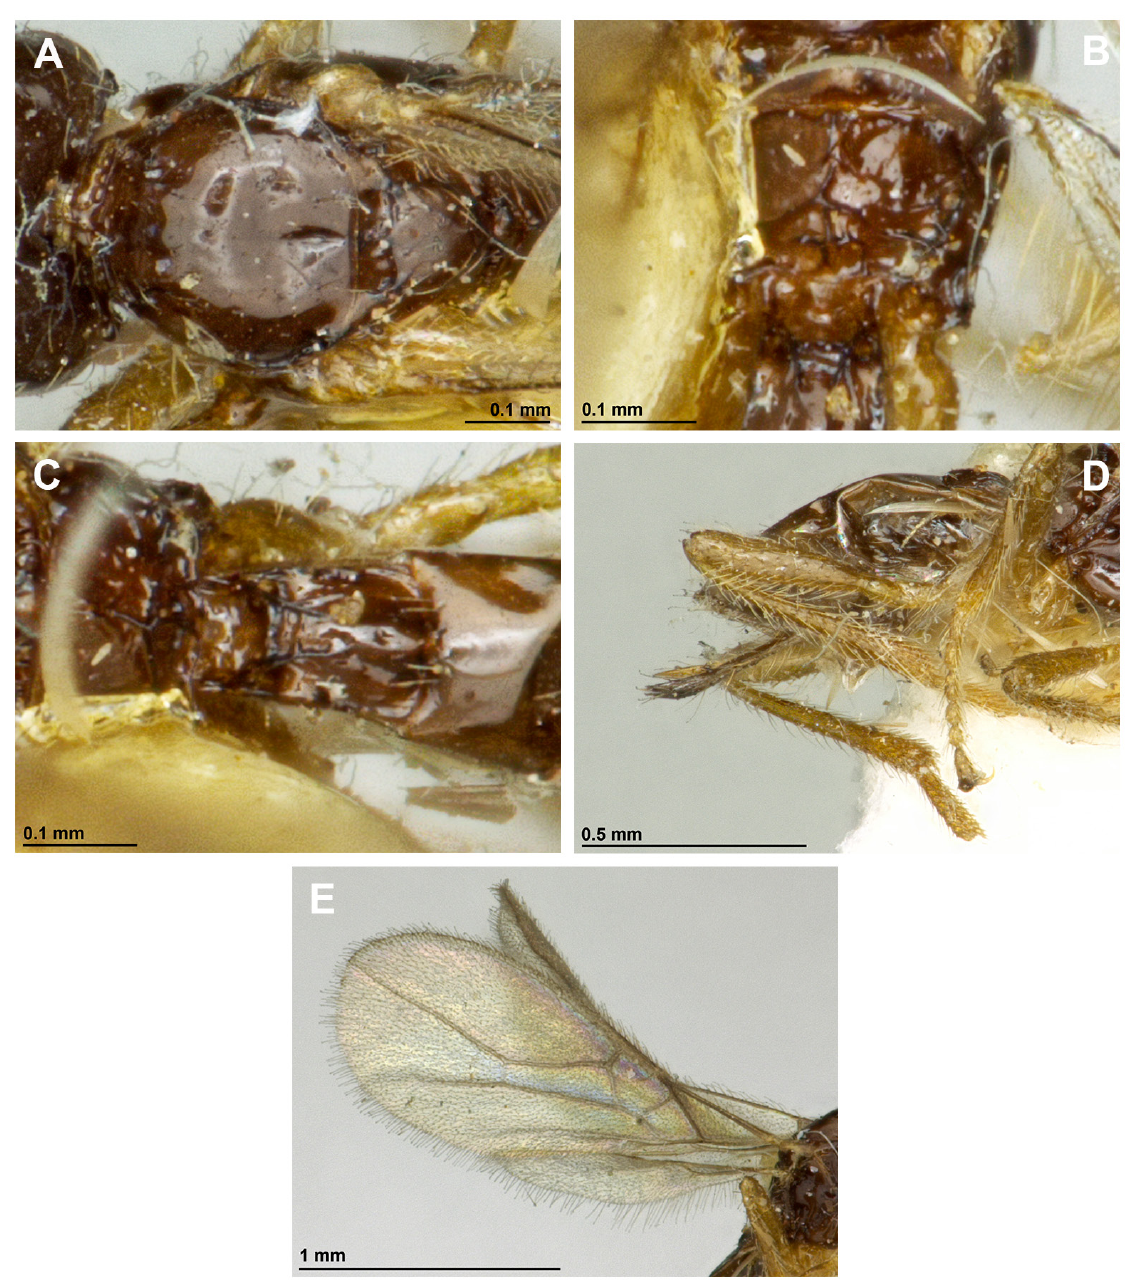
Fig. 47. Asobara notleyi Peris-Felipo, sp. nov., ♀, holotype (BMNH). A . Mesoscutum, dorsal view. B . Propodeum, dorsal view. C . First metasomal tergite, dorsal view. D . Hind leg, metasoma and ovipositor, lateral view. E . Fore and hind